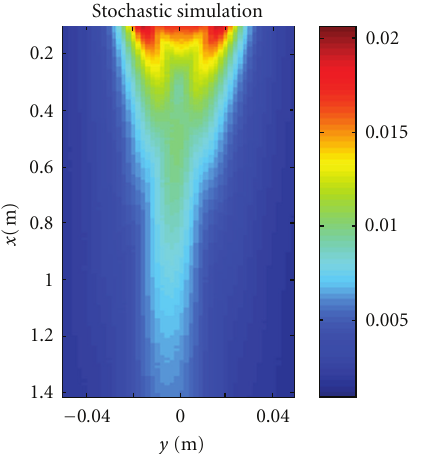
Figure 10: Acoustic beam propagation in inhomogeneous medium calculated by stochastic simulation mode (acoustic source position is at [ x = 0; − 0 . 02 < y < 0 . 02] coordinates).